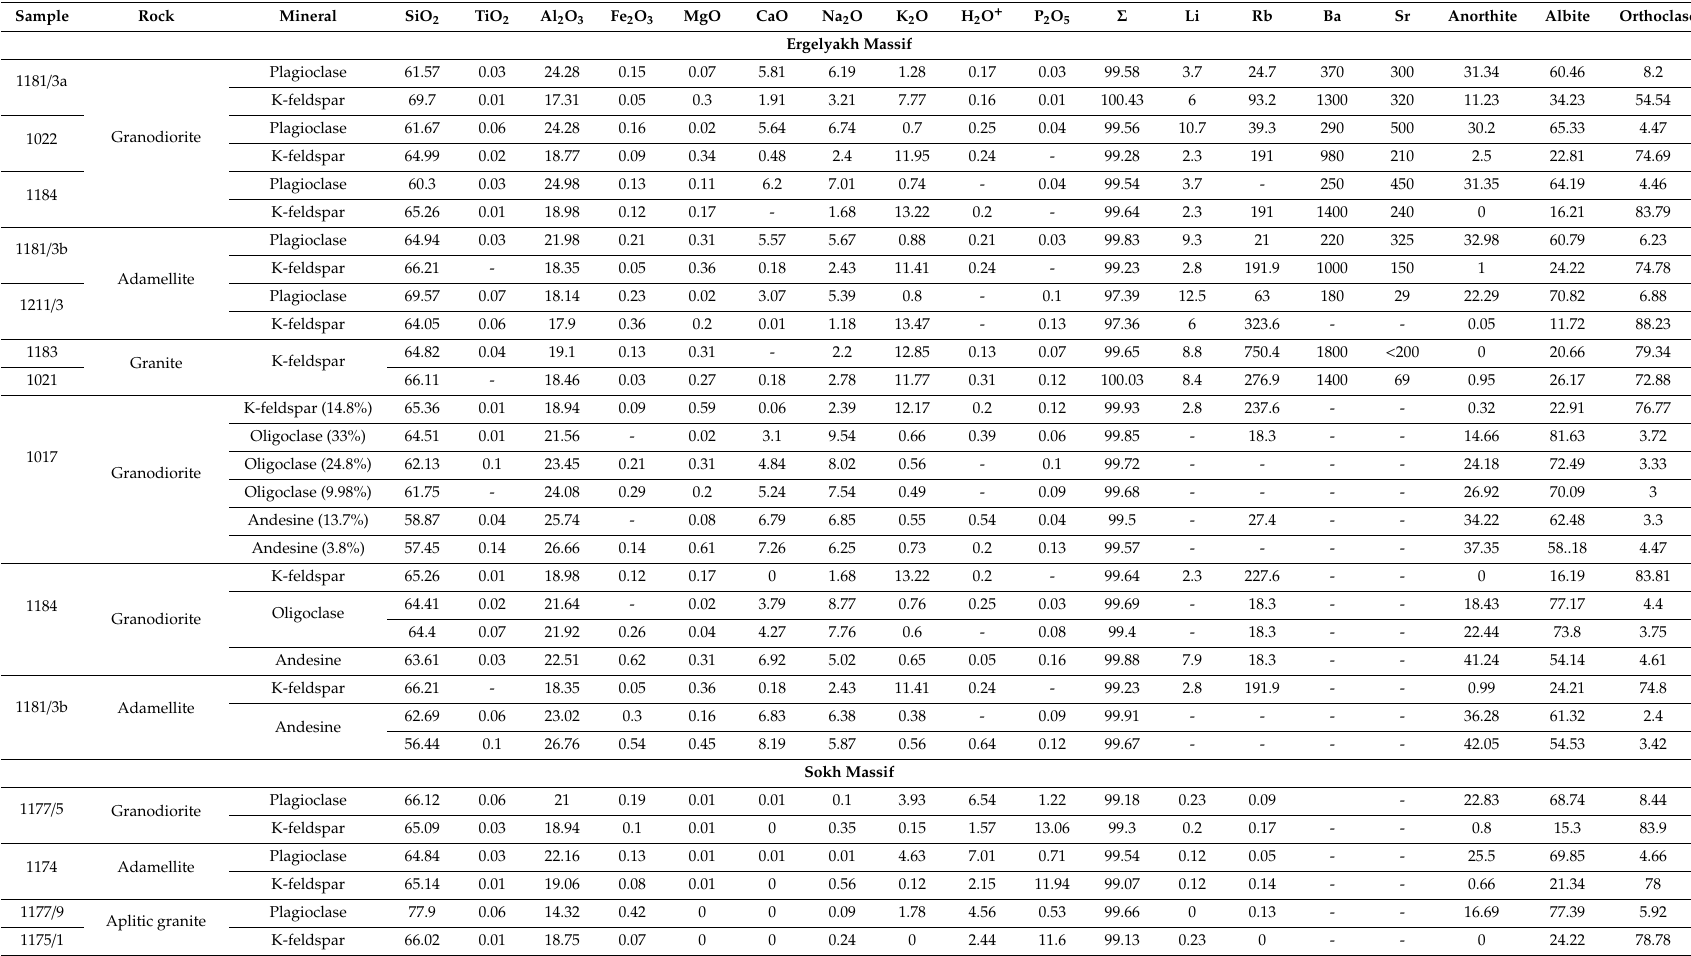
Table 2. Chemical analysis of major and trace elements of feldspars from Ergelyakh and Sokh massifs.